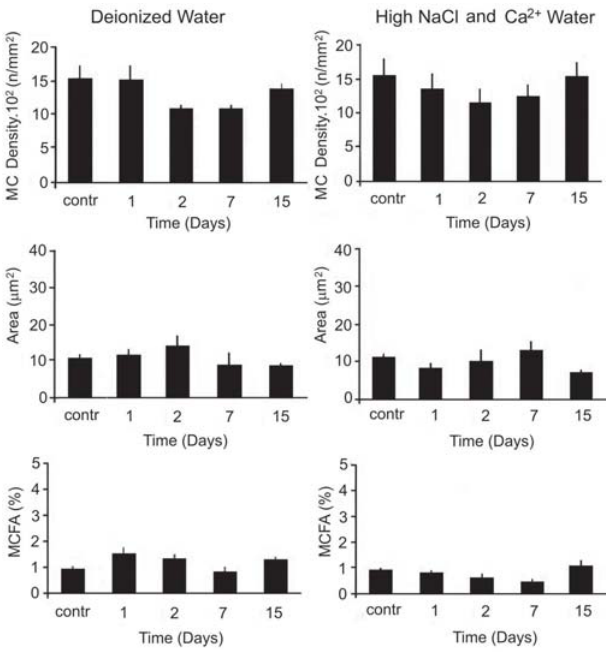
Fig. 4. Mean values (± SEM) of mucous cell density, individual surface area and mucous cell fractional area (MCFA) at filament epithelial surface of Hoplerythrinus unitaeniatus exposed to deionized water and high ion concentration